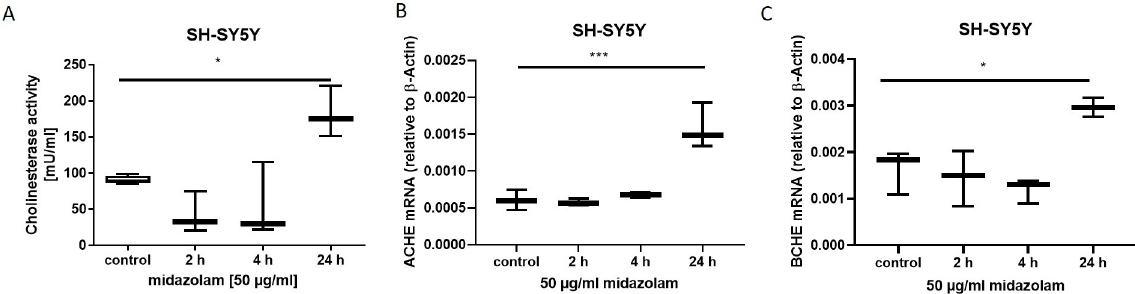
Fig 1. Activity and mRNA expression of AChE and BChE after incubation with midazolam A) the intracellular cholinesterase activity increased 24 h after midazolam exposure (n = 4; p = 0.01) and was measured by fluorometric assay B) ACHE mRNA quantified by qPCR expression was increased 24 hours after midazolam exposure in SH-SY5Y cells (n = 3; p < 0.01) C) BCHE mRNA quantified by qPCR expression was increased 24 hours after midazolam exposure in SH-SY5Y cells (n = 3; p = 0.03). Data are presented as mean ± standard deviation. The reported p-value refers to the Dunnett’s post-hoc test, comparing the underlying columns at the ends of each bar.